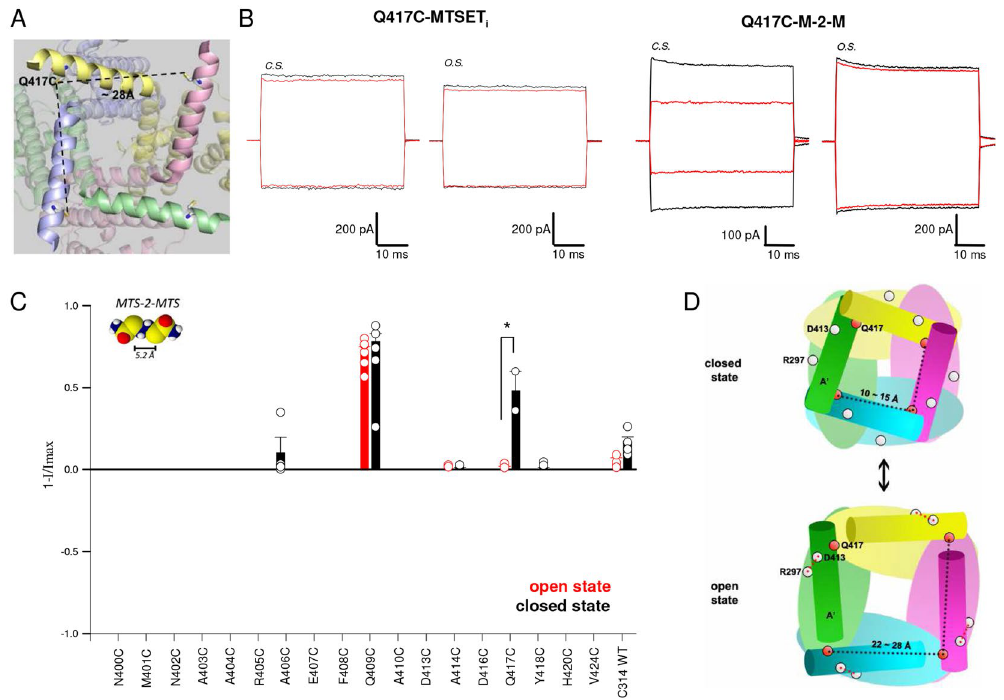
Figure 7. Cysteine scanning mutagenesis in S6 and analysis of M-2-M compound in the open and closed states. ( A ) Mapping of Q417C mutant channel on TAX-4 structure (PDB ID: 5H3O): its distance between adjacent subunits is more than 25 Å apart. ( B ) left: the cGMP-activated currents at ± 60 mV for the mutant channels Q417C before (black) and after (red) 5 minutes application of 2.5 mM MTSET to the intracellular side ( MTSET i ) in the closed (c.s.) and open (o.s.) states. Right: the cGMP-activated currents at ± 60 mV for the mutant channels Q417C before (black) and after (red) 5 minutes application of 100 µ M M-2-M in the closed and open states. ( C ) Histograms representing the average ± s.e.m, after the application of 100 µ M M-2-M in the open (red) and closed (black) states. Significativity is shown only for mutants where the M-2-M effect was > 30%. Unpaired two–tail T-test for Q409C: t 8 − 9,907; P < 0.001. Unpaired two–tail T-test for Q417C: t 12 = − 6,57, P < 0.05. Further statistical tests for these mutant channels and for all other tested mutants are reported in Supplementary Table 2f. 1-I/Imax represents the normalized current where I is the residual current measured in the presence of 1 mM cGMP after the application of M-2-M and Imax is the cGMP activated current at the beginning of the experiment. ( D ) Schematic representation of mutant channels Q417C highlighting that residues Q417 belonging to adjacent subunits have a different distance in the closed and open